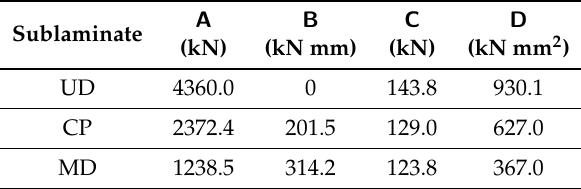
Table 4. Sublaminate equivalent beam